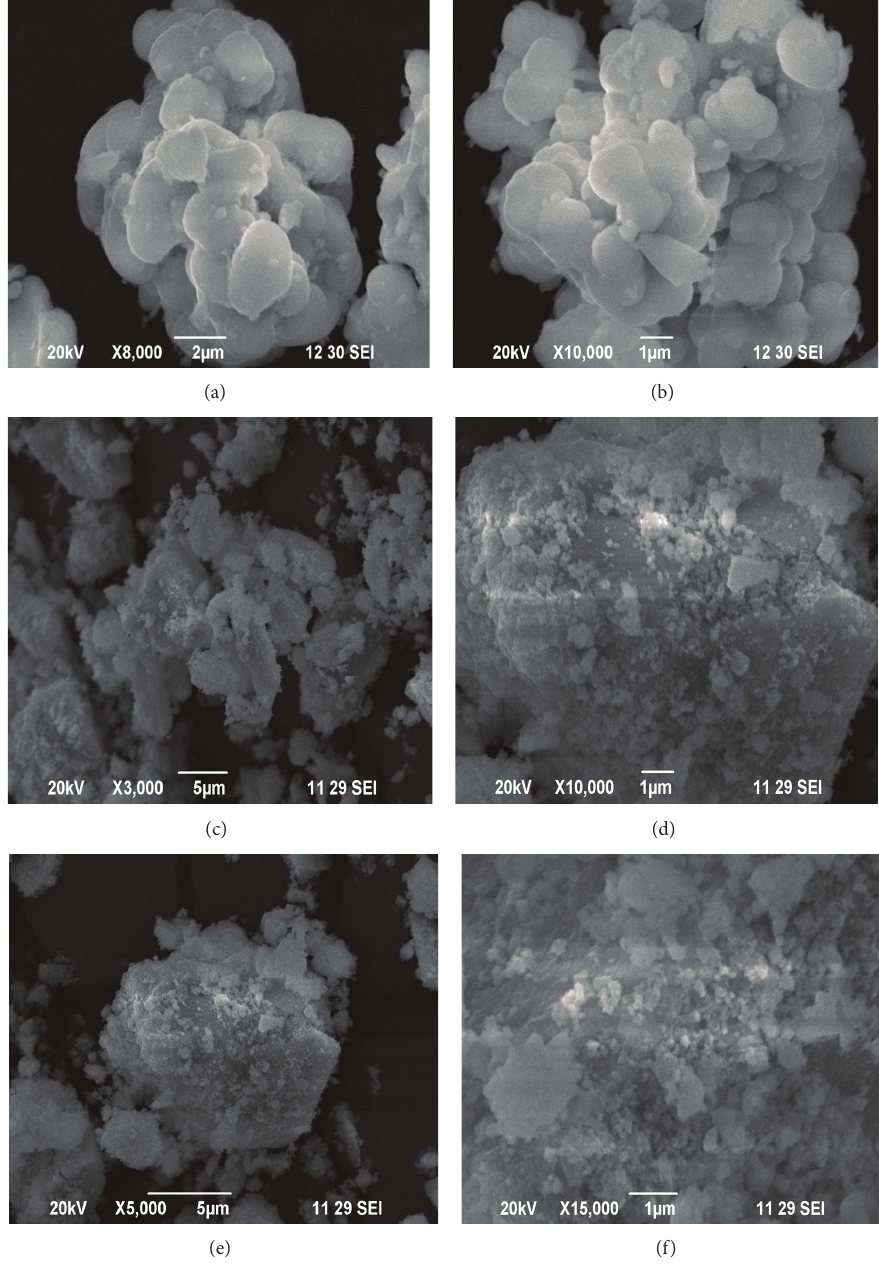
Figure 2: [(a)-(b)]: SEM images of coarse zirconia; [(c)–(f)]: SEM images of synthesized zirconium